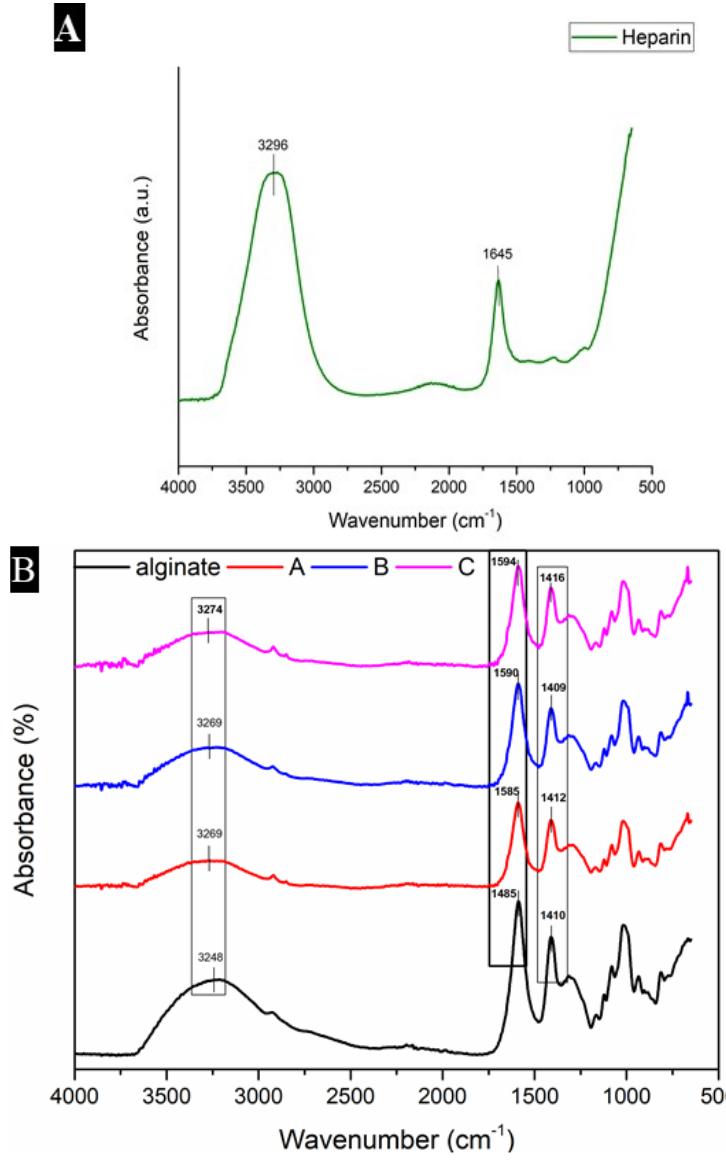
Figure 1. This figure shows the FTIR analysis of heparin ( A ), and other samples ( B ). In Figure 1B, the spectra of “alginate” represent control, “A” represents sample A, “B” represents sample B and “C” represents sample C in the spectral region (4000–500 cm − 1